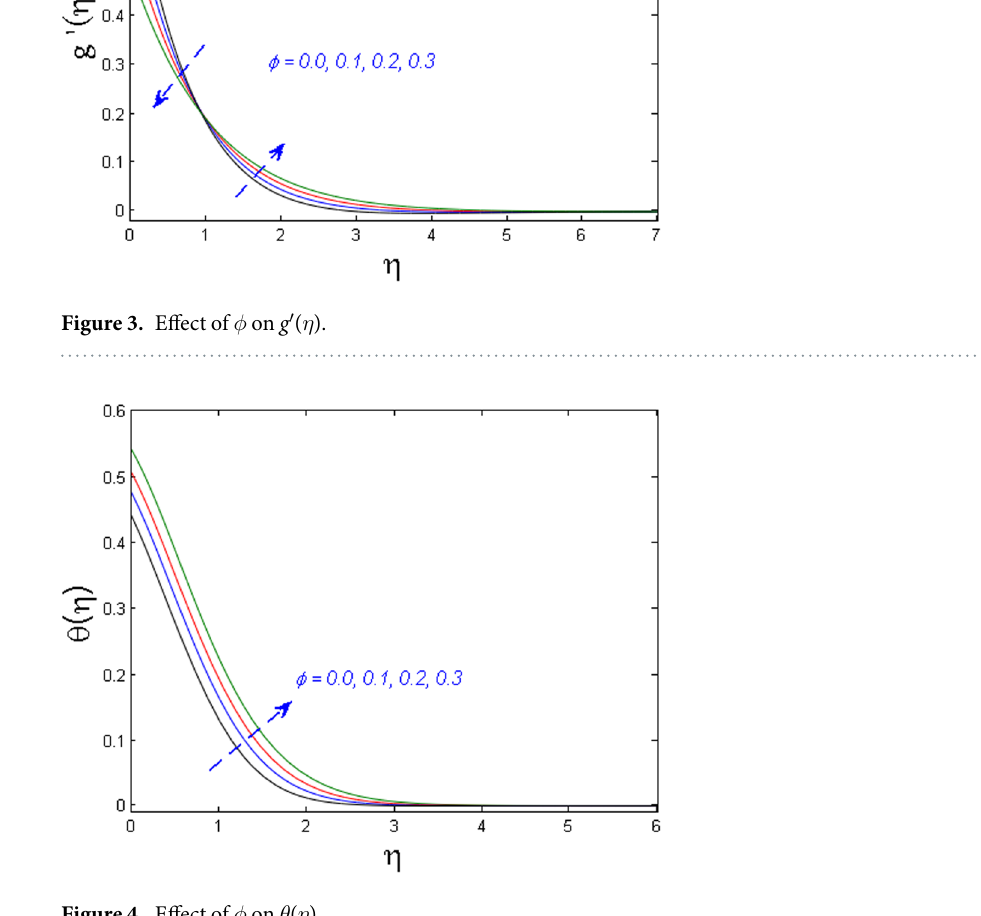
Figure 4. Effect of φ on θ ( η